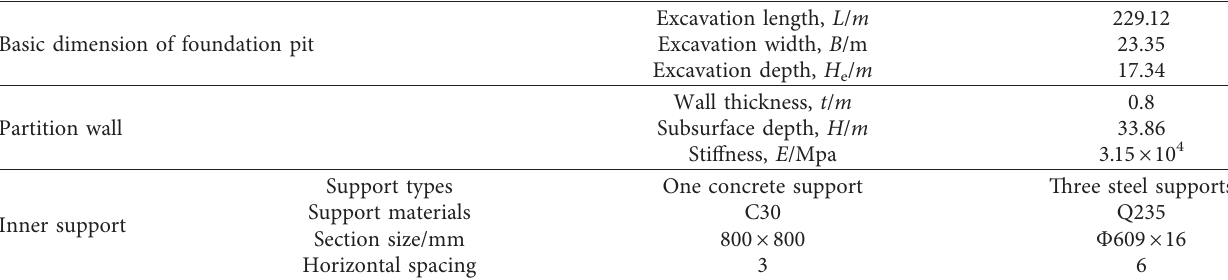
Table 3: Main parameters of the normalized